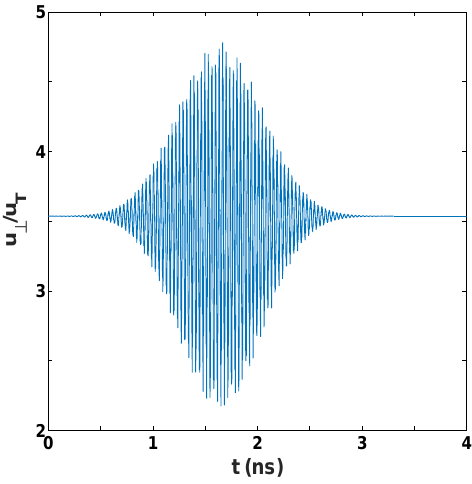
Figure 2. The evolution of u ⊥ / u T as a function of time for the same parameters as in Fig. 1; u ⊥ / u T = √ + p 2 / p p 2 y x